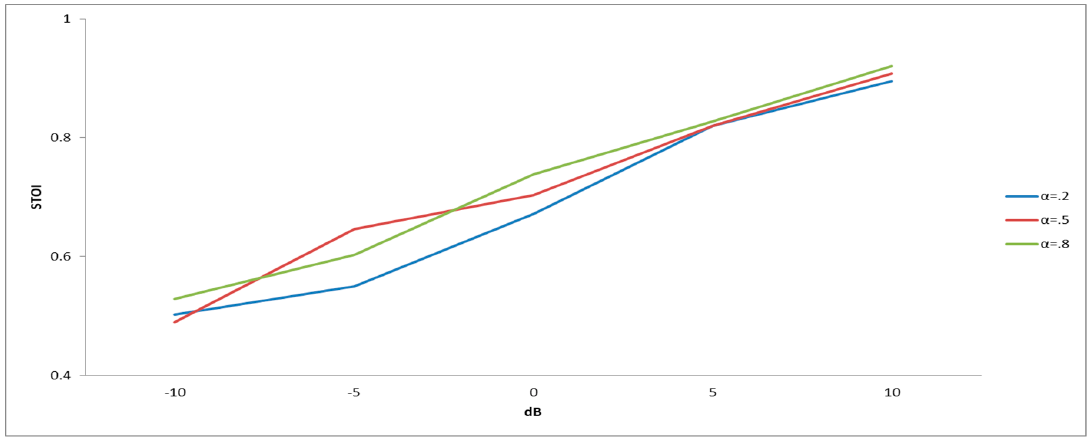
Figure 6. Effect of ssRM regarding the value of α .